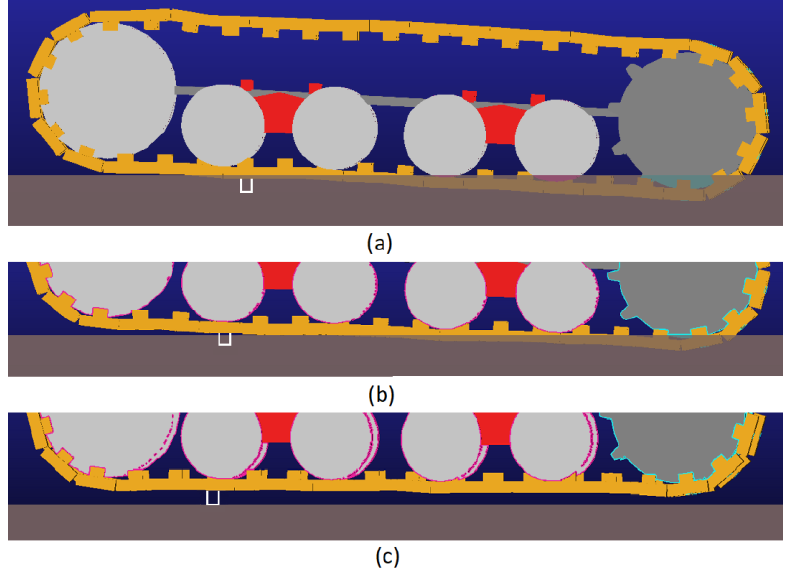
Figure 18. Tracks sinkage with 12 mm high grousers on sand ( a ), 25 mm high grousers on sand ( b ), and 25 mm high grousers on compact terrain ( c ). In each figure, only one virtual grouser is represented on each image to figure out the track